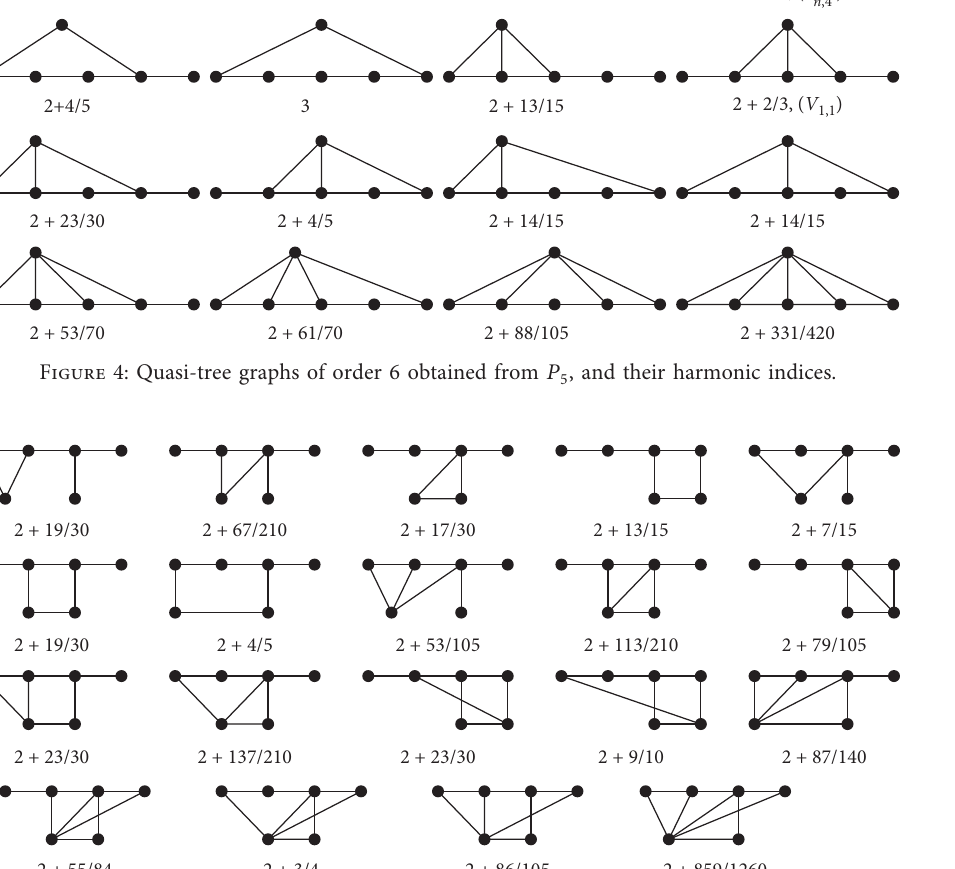
, and their harmonic 1 , 3